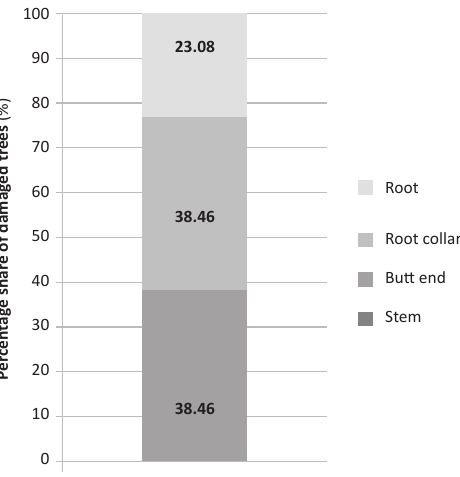
FIgURe 5. The distribution of damages depending on dama- ge position.